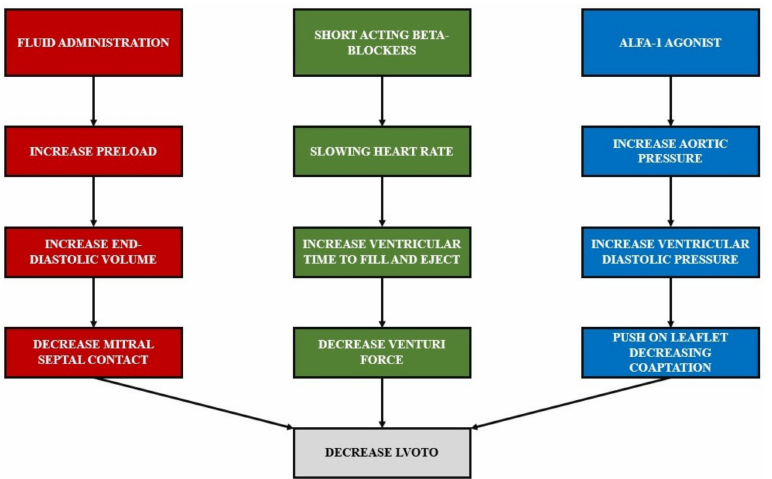
Figure 2. Three pillars of the hemodynamic management of SAM: increase preload, decrease heart rate, and increase